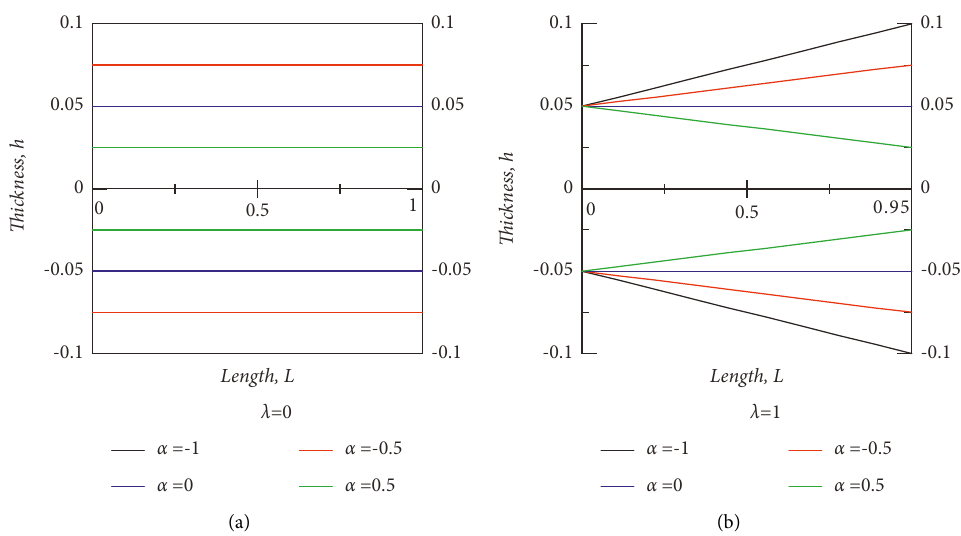
Figure 2: Change of thickness profile according to thickness variation parameter α